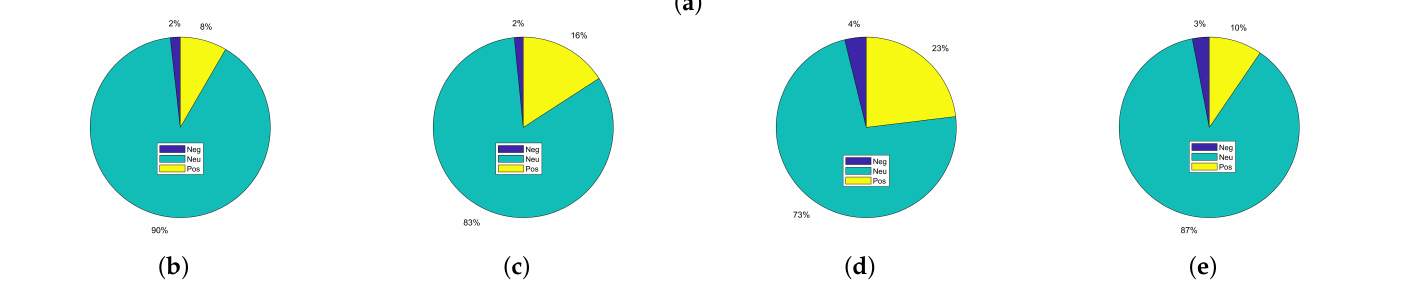
Figure 3. Sentiment distribution of the collected dataset.